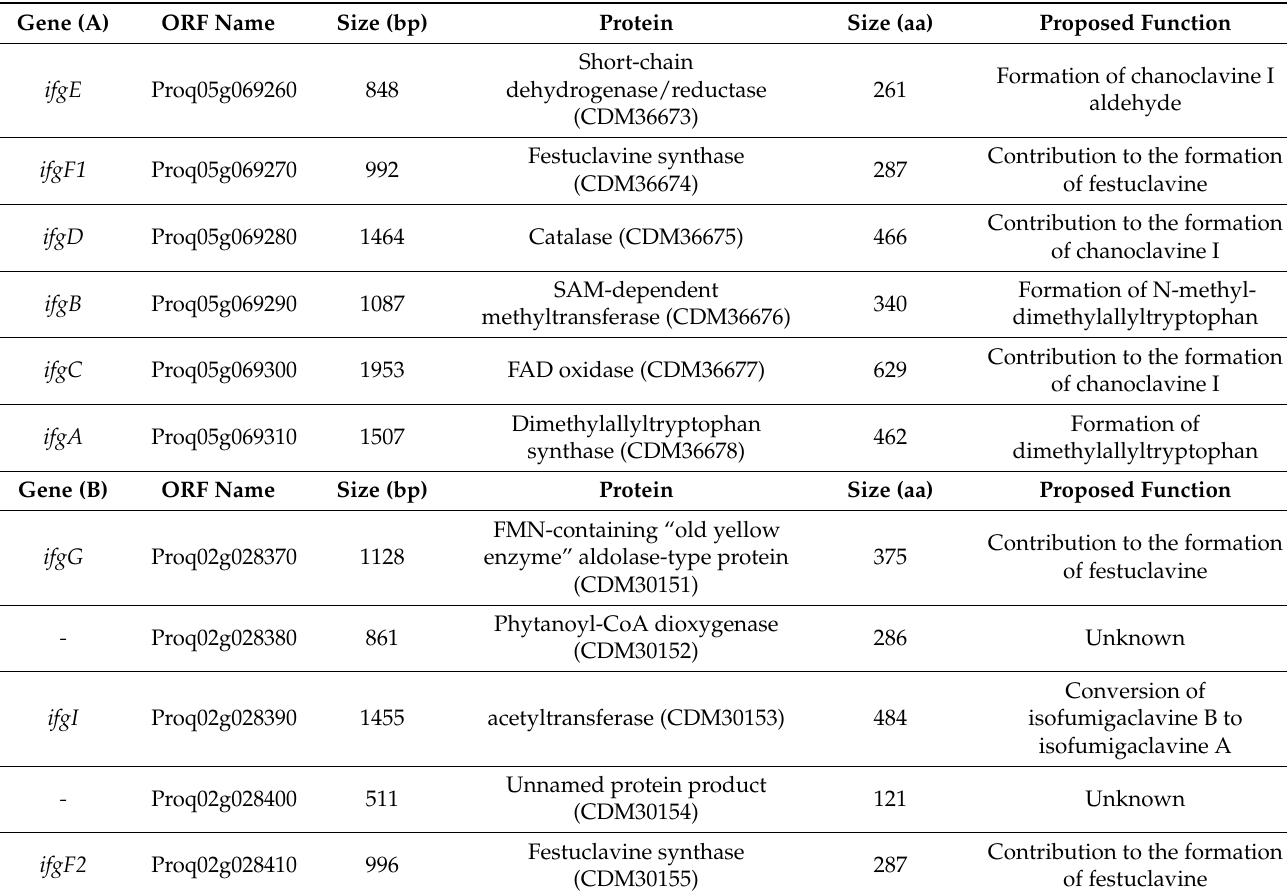
Table 2. Isofumigaclavine A biosynthetic gene clusters (A) and (B) in P. roqueforti